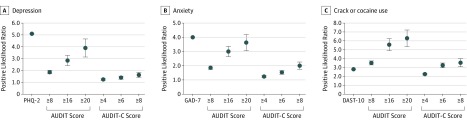
Test Performance of Alcohol Screening Scores for Identification of Depression, Anxiety, and Crack or Cocaine UseA, Values are shown for the Patient Health Questionnaire–2 (PHQ-2) vs Alcohol Use Disorders Identification Test (AUDIT) and Alcohol Use Disorders Identification Test–Consumption (AUDIT-C) for detection of depression. B, Values are shown for the Generalized Anxiety Disorder 7-Item Scale (GAD-7) vs AUDIT and AUDIT-C for detection of anxiety. C, Values are shown for the Drug Abuse Screen Test (DAST-10) vs AUDIT and AUDIT-C for detection of crack or cocaine use. Error bars denote 95% CIs.